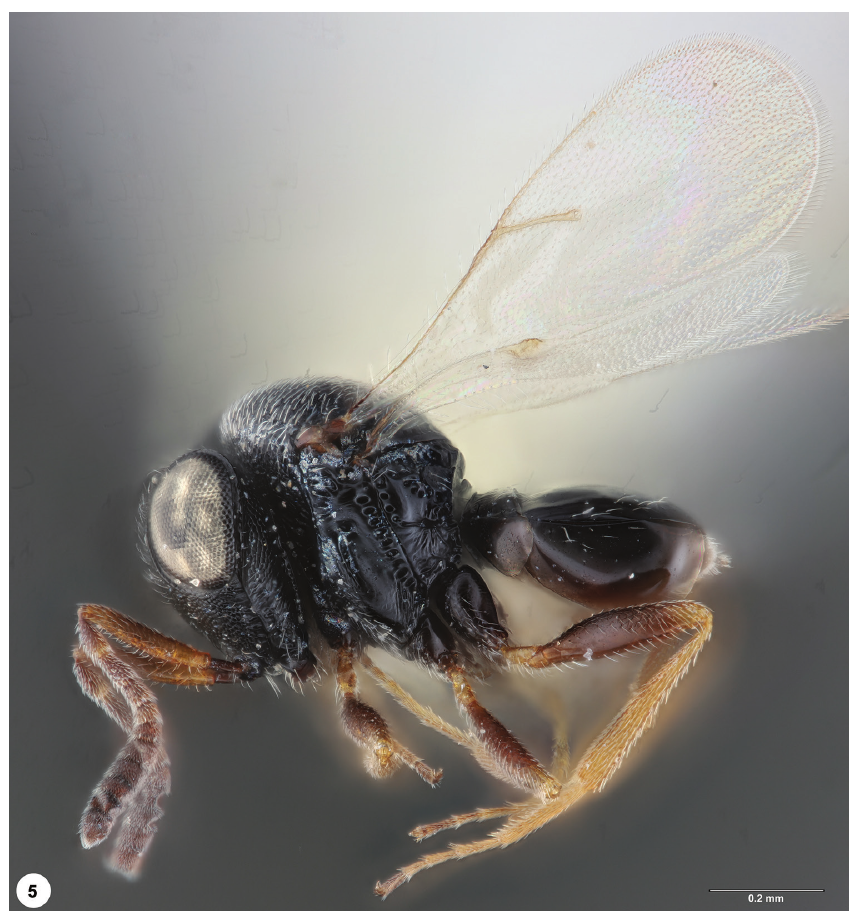
Figure 5. Trissolcus colemani (FSCA 00094244), lateral habitus.